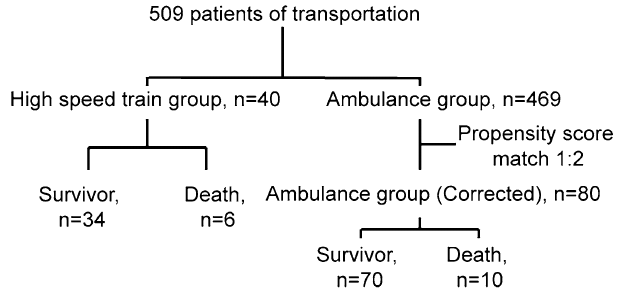
Figure 3. Workflow for the matching of subjects in 509 children in this study.